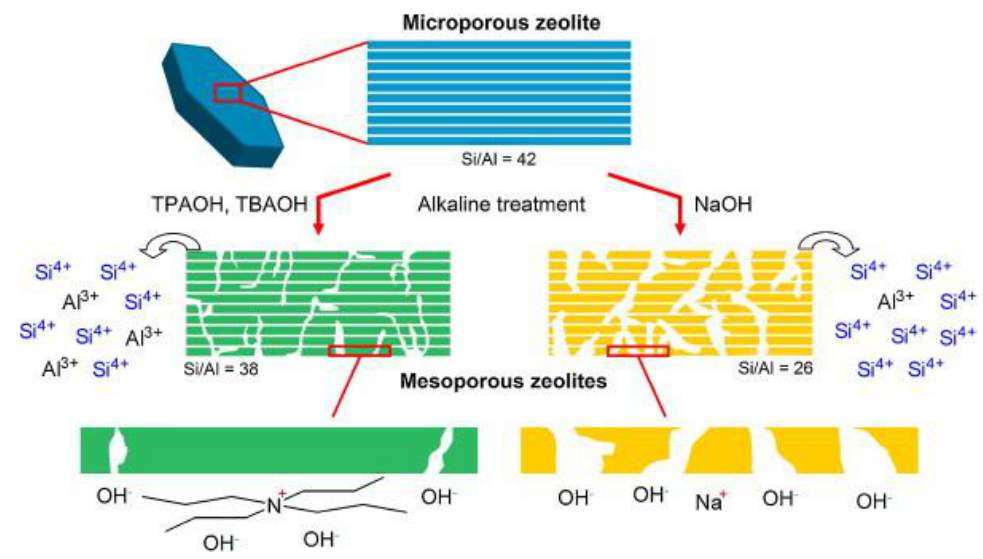
Figure 12. Pictorial comparison of zeolite desilication by tetraalkylammonium hydroxides and sodium hydroxide [93]. Copyright Elsevier,